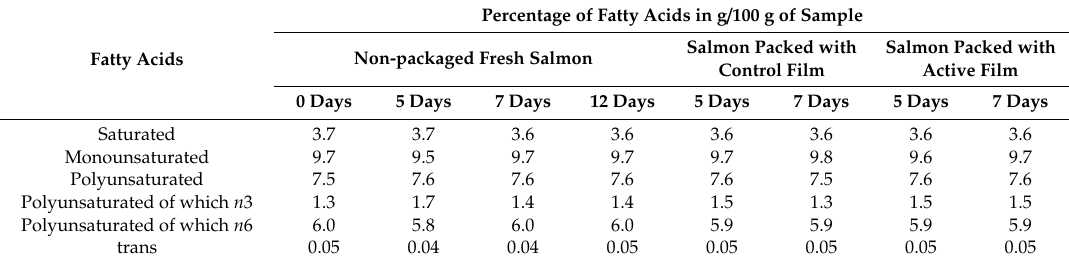
Table 5. Fatty acids present in fresh salmon, non-packaged, packaged with control film and packaged with active film. Percentage of Fatty Acids in g / 100 g of Sample Salmon Packed with Salmon Packed with Non-packaged Fresh Salmon Fatty Acids Control Film Active Film 0 Days 5